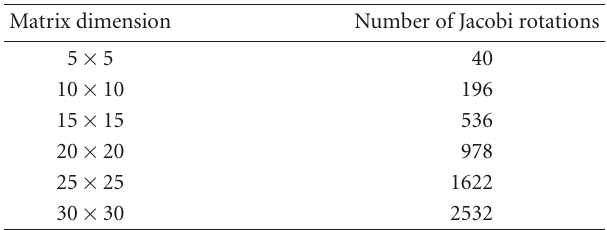
Table 6: Jacobi SVD algorithm: number of Jacobi rotations for dif- ferent matrix